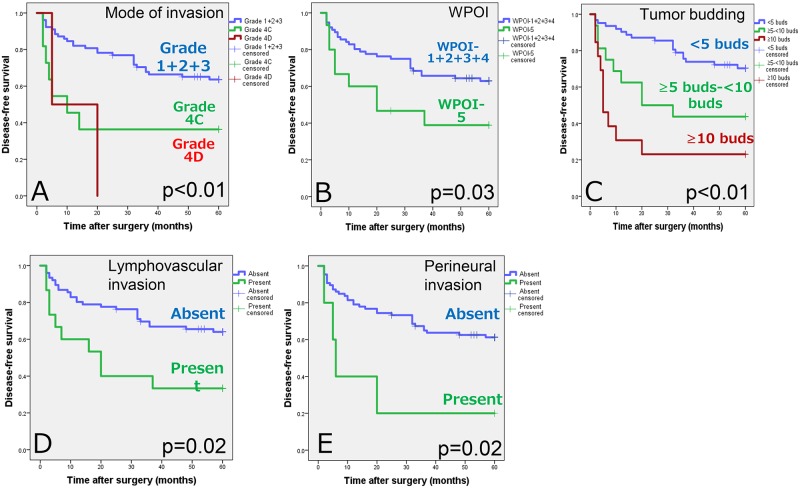
Kaplan-Meier survival curves by mode of invasion (A), worst pattern of invasion (WPOI) (B), tumor budding (C), lymphovascular invasion (D), and perineural invasion (E).5-year disease-free survivals were 58.0% for grade 1+2+3 mode of invasion, 36.4% for grade 4C mode of invasion, 0.0% for grade 4D mode of invasion (A), 58.4% for WPOI-1+2+3+4, 33.3% for WPOI-5, 65.0% for low-intensity tumor budding (<5 buds), 37.5% for intermediate-intensity tumor budding (≥5 buds-<10 buds), 23.1% for high-intensity tumor budding (≥10 buds), 58.1% for absence of lymphovascular invasion, 33.3% for presence of lymphovascular invasion, 56.1% for absence of perineural invasion, and 20.0% for presence of perineural invsion in patients with clinically node-negative T1 and T2 oral squamous cell carcinoma.